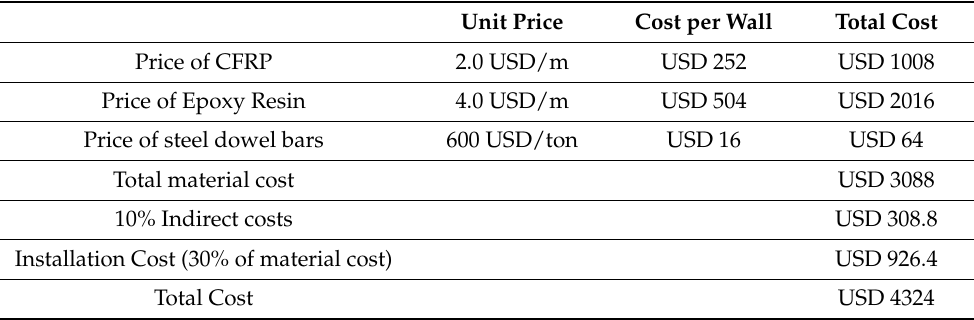
Table 6. Summary of the added cost for reinforcing a simple residential